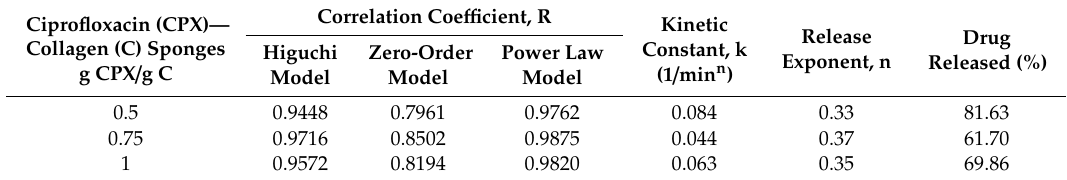
Table 1. Correlation coe ffi cients (R) for Higuchi, Zero-order, and Power law kinetic models; kinetic parameters specific to the Power law model and cumulative ciprofloxacine released